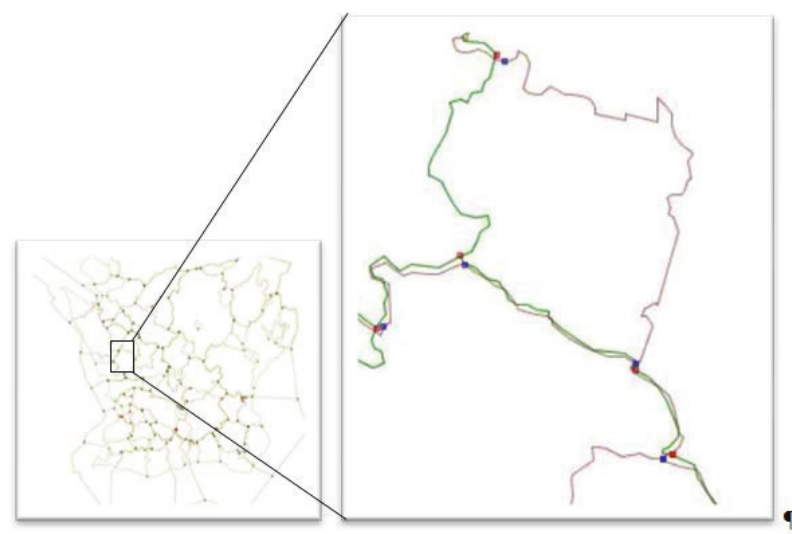
Figure 4: Corresponding nodes for the application-specific layer and the